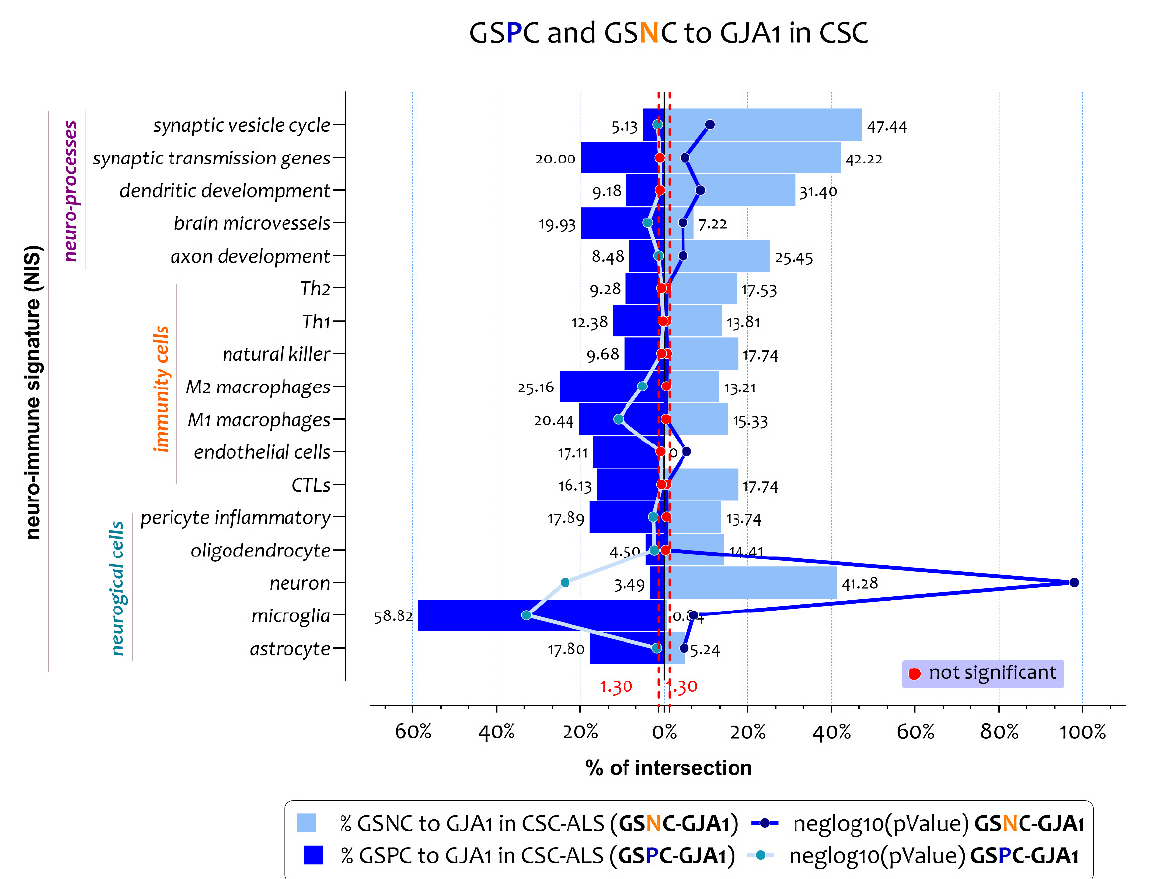
Figure 2. Neuro-immune signature deconvolution analysis obtained by GSPC/GSNC-GJA1 in the spinal cord of ALS patients. The intersection of gene lists positively/negatively (GSPC/GSNC) correlated to GJA1 expression levels in ALS patients to the 17 neuro-immune signatures belonging to the CNS cells (n = 5), the immune cells (n = 7), and biological processes (n = 5). The genes in common obtained from the overlaps are expressed in percentages and represented as a bar chart.